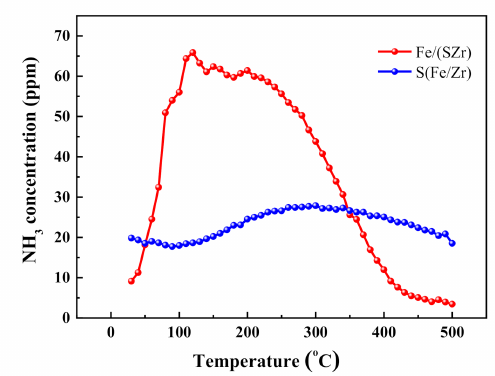
Figure 6. NH 3 –TPD profiles of sulfated iron-based catalysts. Reaction conditions: 0.05% NH 3 , N 2 balanced, 300 mL / min, and 0.5